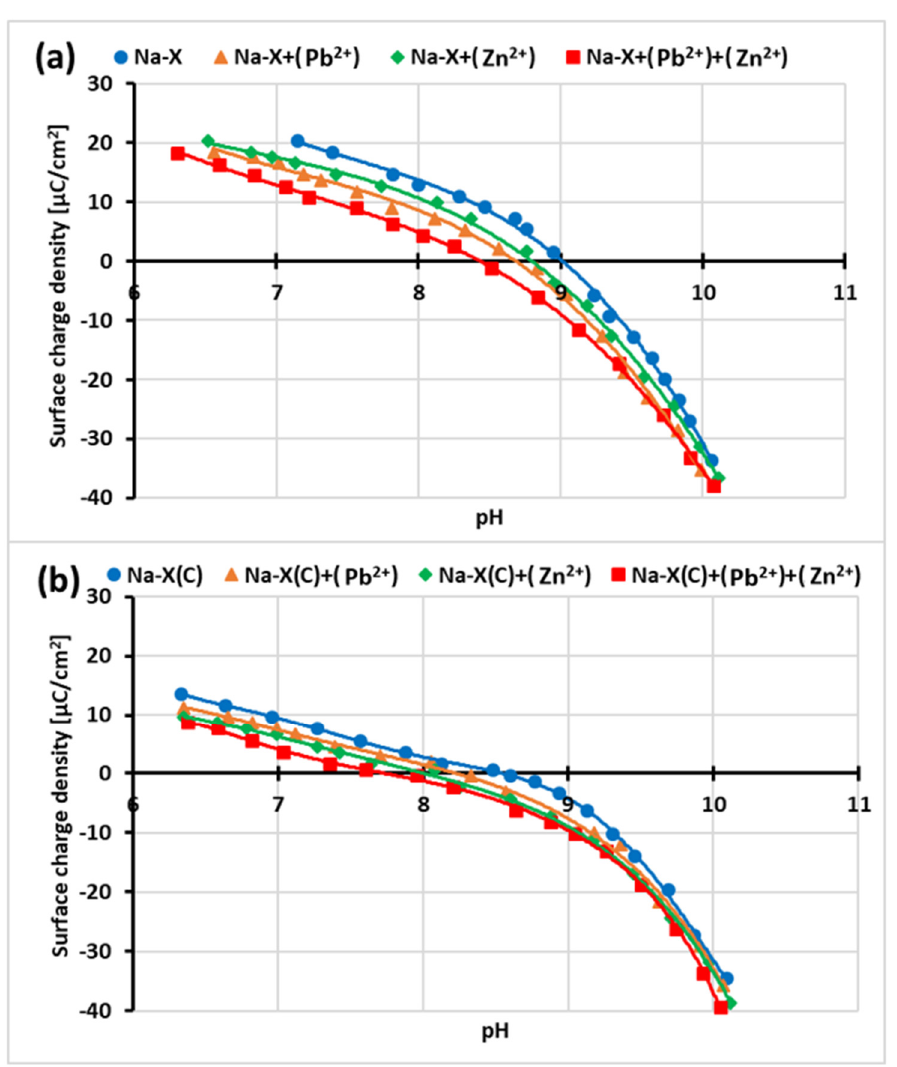
Figure 10. Surface charge density vs. solution pH of Na-X ( a ) and Na-X(C) ( b ) with and without one or two heavy metal ions.